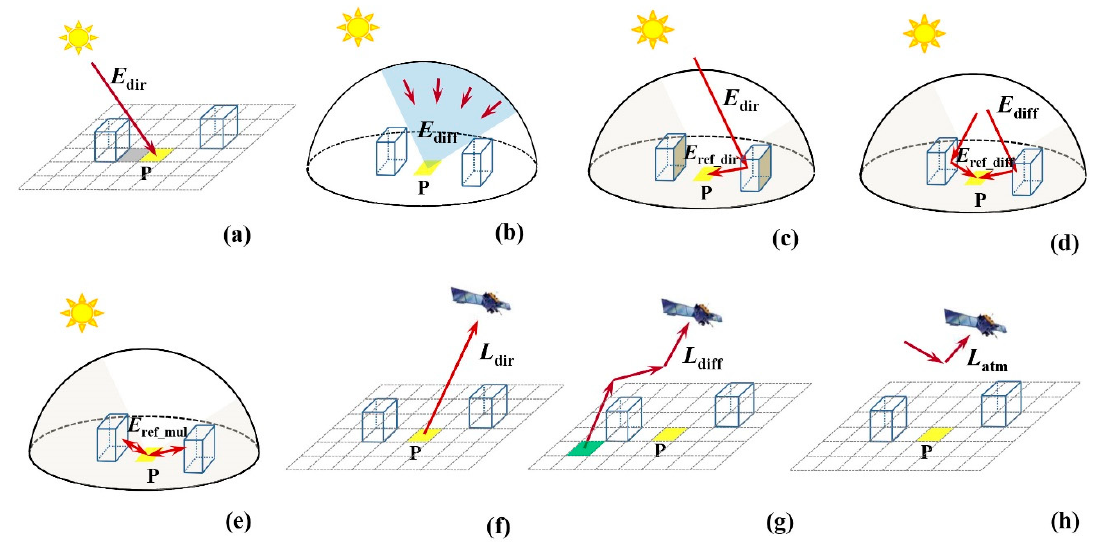
Figure 1. Schematic presentation of the urban solar radiative transfer processes: ( a ) solar direct irradiance; ( b ) sky diffuse irradiance; ( c ) reflected part of the solar direct irradiance; ( d ) reflected part of the sky diffuse irradiance; ( e ) superimposed part of the multiple reflections; ( f ) target pixel radiance; ( g ) upward diffuse radiance; ( h ) path radiance.